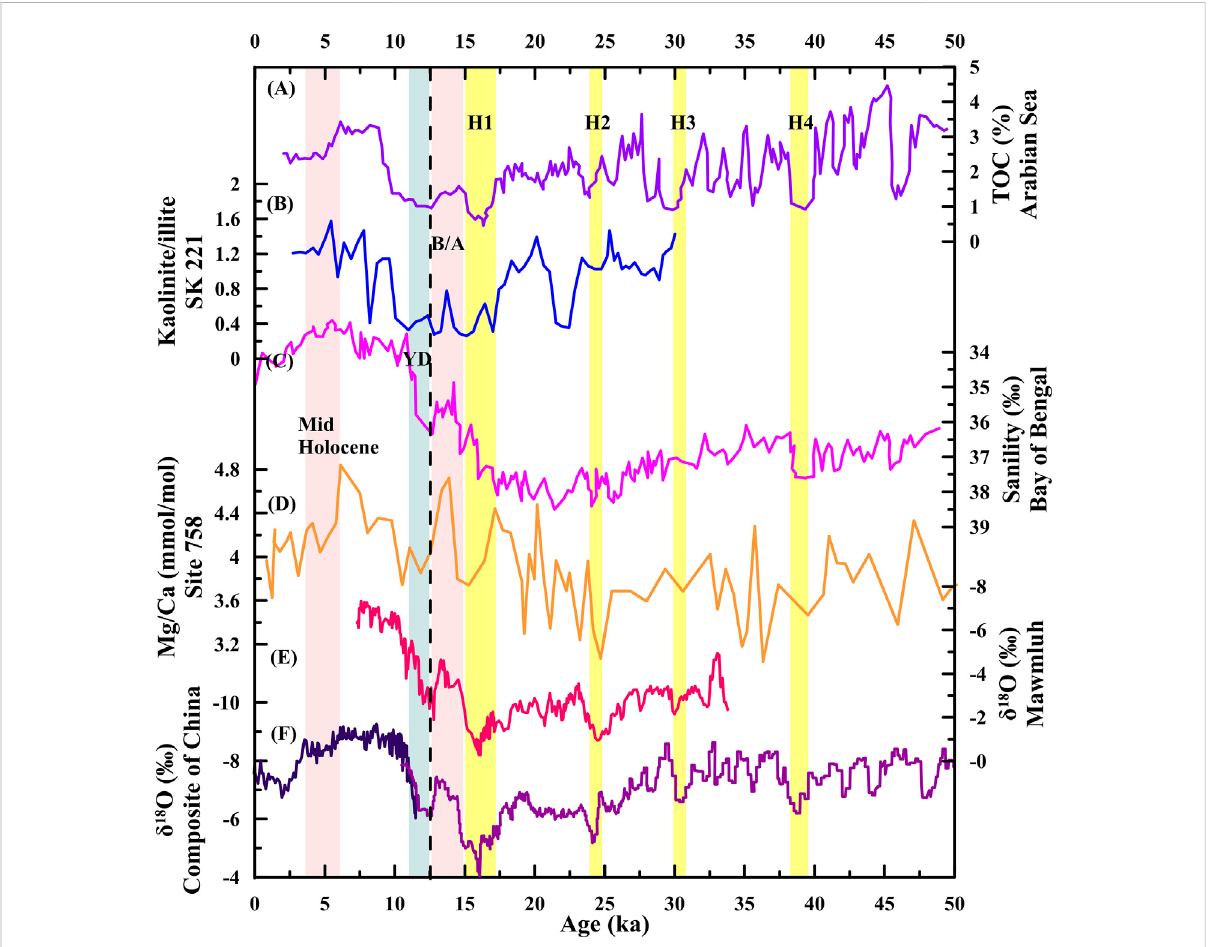
FIGURE 4 ComparisonbetweenhighresolutionISMrecords. (A) Totalorganiccarbon(TOC)contentfromArabianSea(Schulzetal.,1998); (B) Kaoliniteto illite ratio from SK 221 in Arabian Sea (Das et al., 2013); (C) Salinity record from KL 126 in Bay of Bengal (Kudrass et al., 2001); (D) Mg/Ca record from Site 758 (Gebregiorgis et al., 2016); (E) δ 18 O record from Mawnluh Cave (Dutt et al., 2015); (F) δ 18 O records from Hulu Cave (Wang et al., 2001) and Dongge Cave (Yuan et al., 2004). Younger Dryas (YD), Bølling-Allerød (B/A), and Heinrich events (H1-4) are shaded based on stratigraphic boundaries de fi ned by NGRIP (Andersen et al., 2006; Rasmussen et al.,